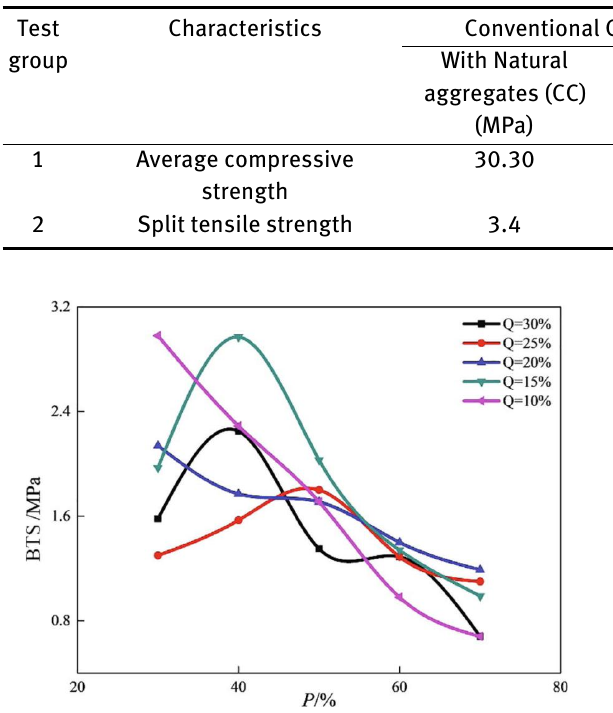
Figure 11: P is the content of waste mudstone and Q is the content of alkali activator